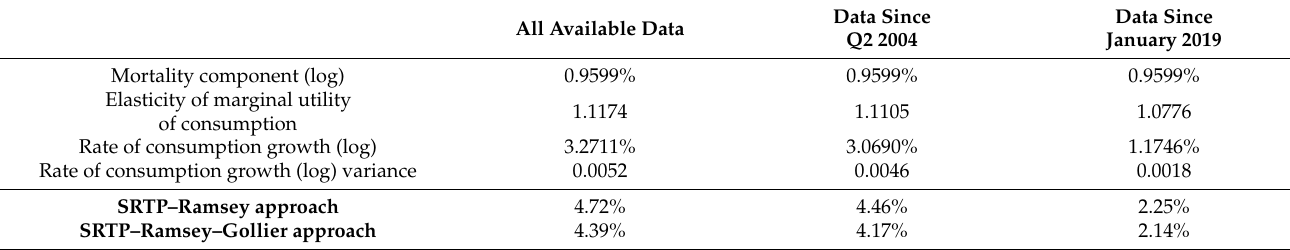
Table 2. Estimates of Social Discount Rate for Poland based on Ramsey and Ramsey–Gollier